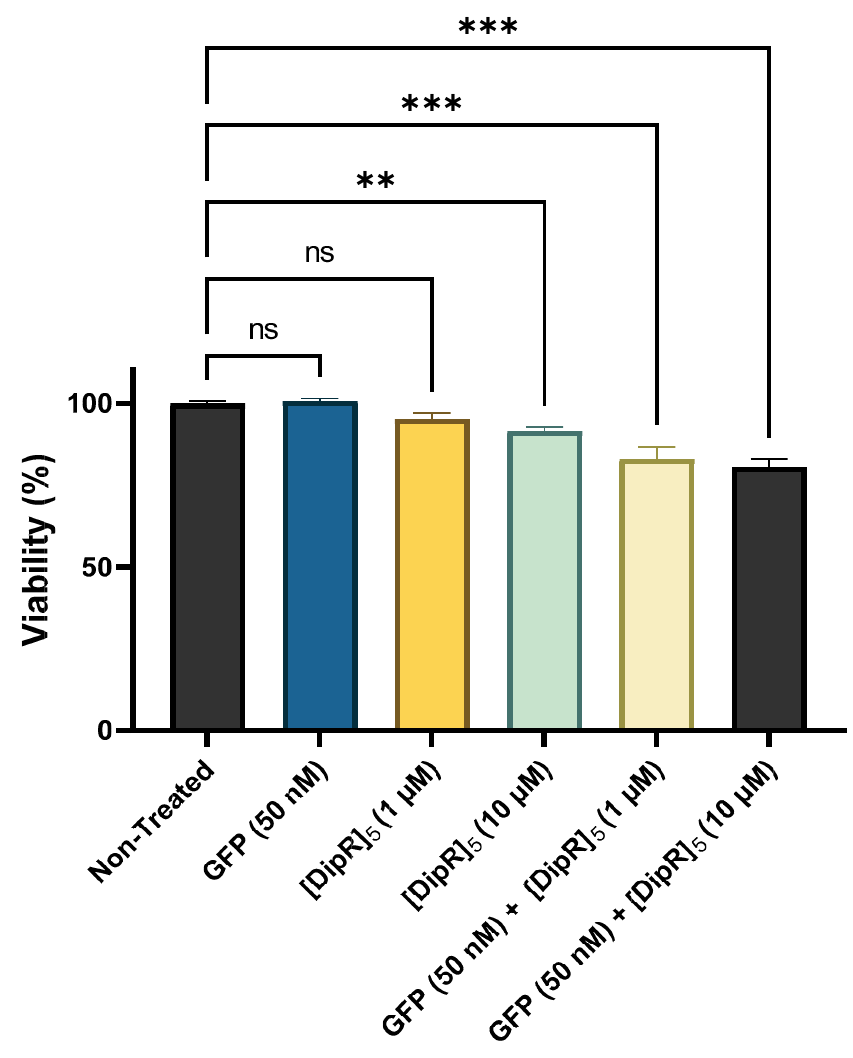
Figure 4. Cytotoxicity of [DipR] 5 with GFP (50 nM) physical mixtures at different peptide concentra- tions (1–10 µ M) in breast cancer (MDA-MB-231) cell line after 3 h. The results are mean ± SD ( n = 3) (ns; no significance, ** p < 0.01, *** p < 0.001 treatments vs. Ctrl (NT).